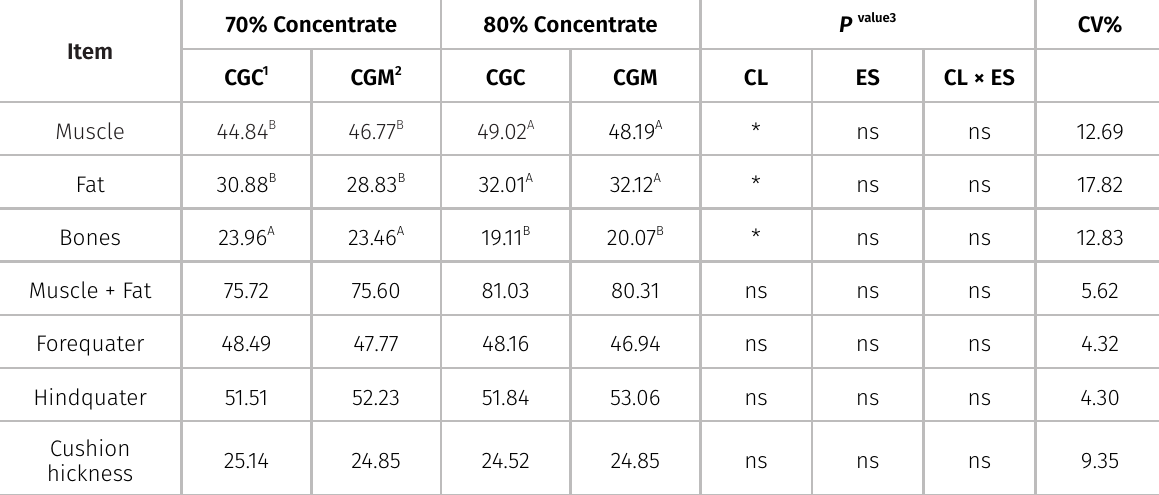
Table IV. Carcass physical composition (%) and cushion thickness (cm) of Nellore heifers fed two concentrate levels and energy